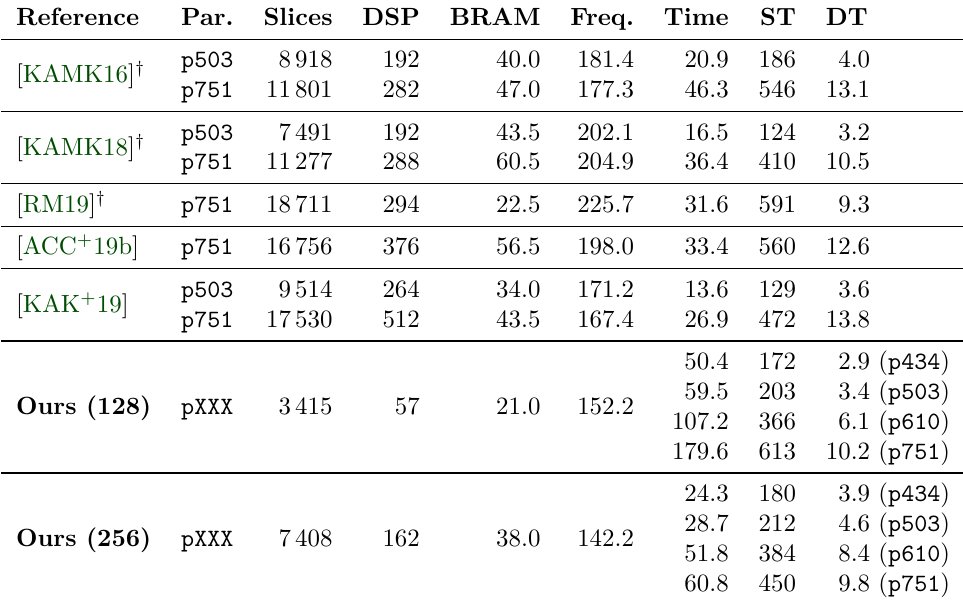
Table 4: Comparison of SIKE implementations on the Xilinx Virtex 7 690T. The frequency (“Freq.”) is measured in Megahertz (MHz) and the total time ( Encaps + Decaps for SIKE, a full ephemeral key exchange for SIDH) in milliseconds (ms). The ST resp. DT column displays the number of slices and DSPs respectively times the time divided by 1000, rounded to the nearest multiple of 1000 resp. 100. Our architecture works directly for any parameter set pXXX for XXX ∈ { 434 , 503 , 610 , 751 } and does not need to be reprogrammed. Works emphasized with a † symbol only implement SIDH, while the others do